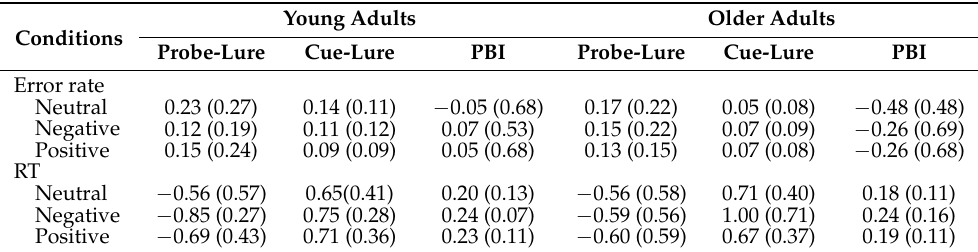
Table 4. Mean error rates and RT median z-scores of the critical cue-lure and probe-lure trials, as well as the PBI scores across age and mood conditions in Experiment